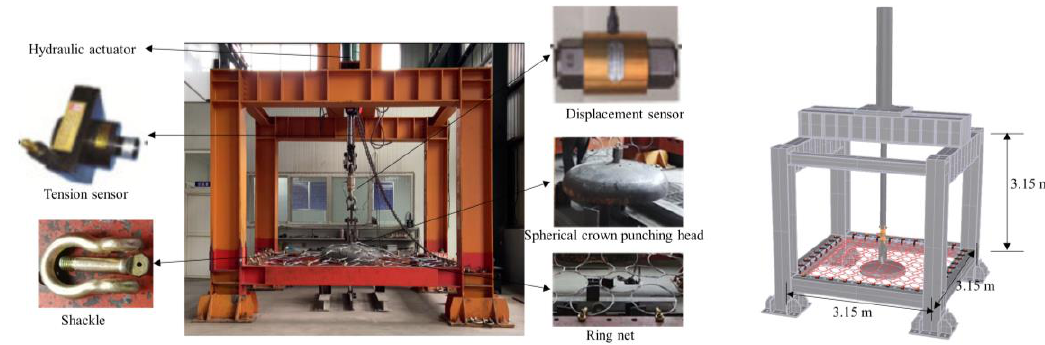
Figure 3. Test equipment.